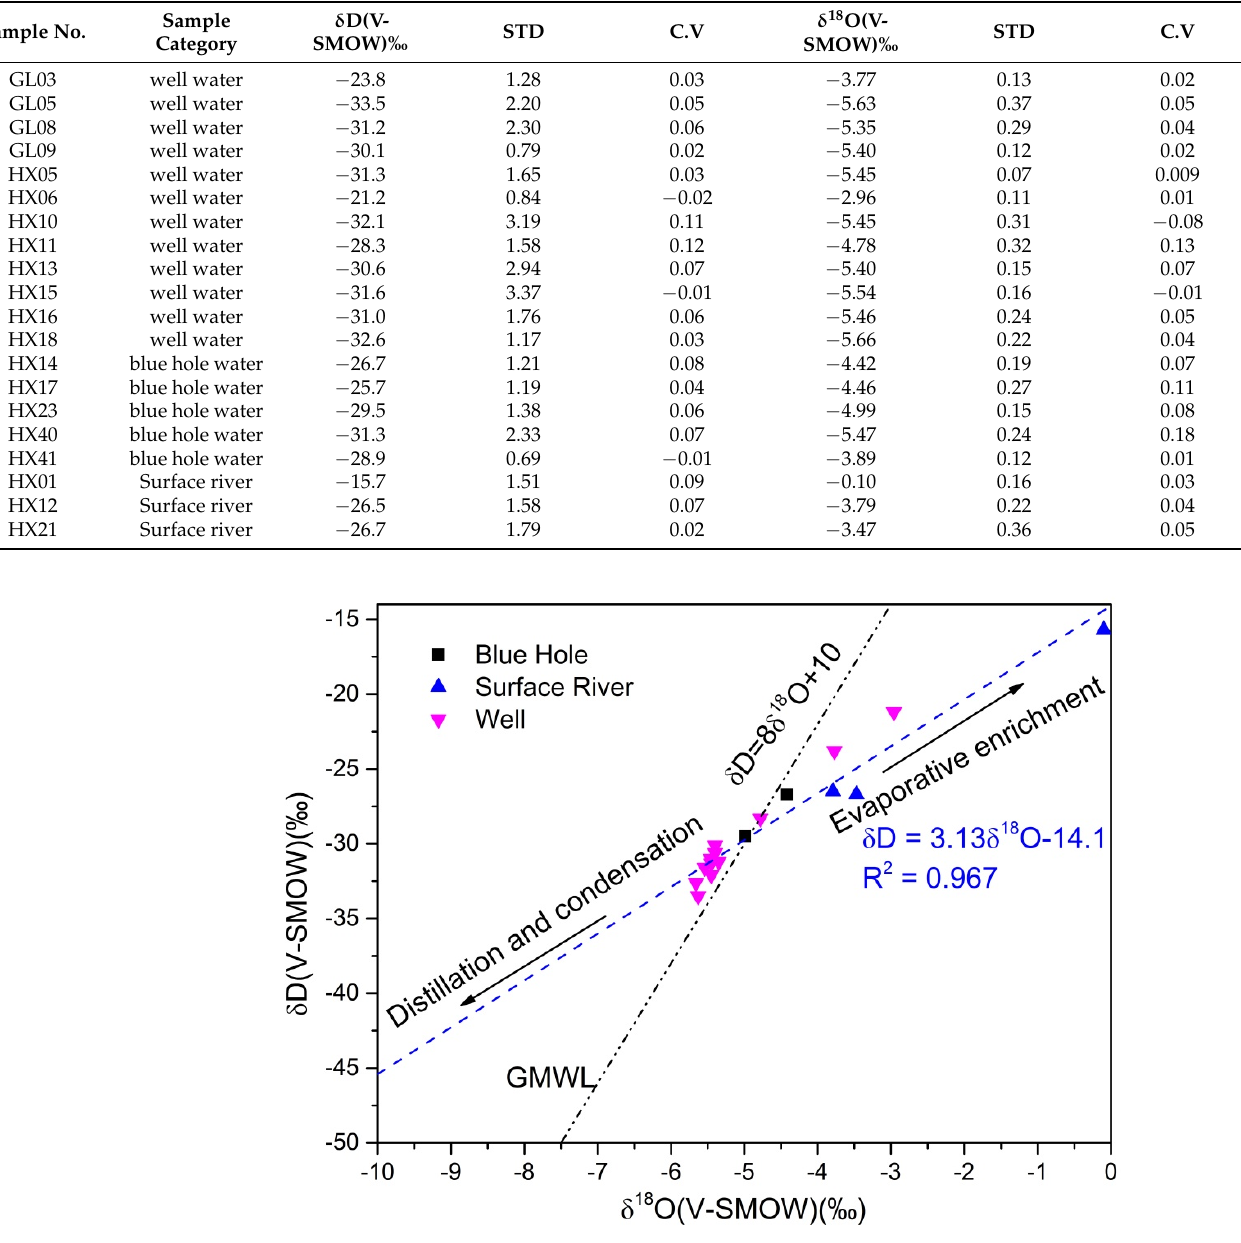
Figure 12. δ 18 O vs. δ D in karst groundwater of the Huixian karst wetland.